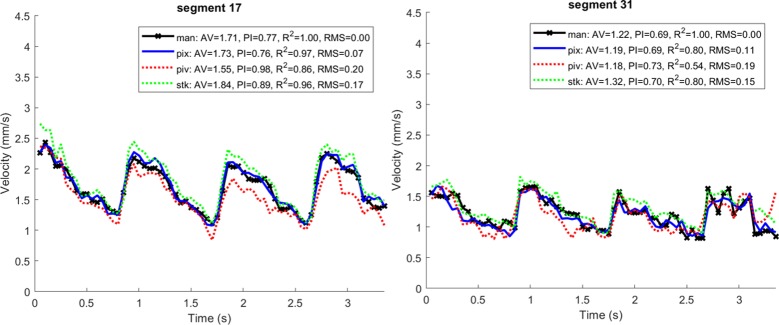
Temporal fidelity in tracking in the face of variability from the cardiac cycle.Sequence was acquired at 300 fps and can be viewed in S3 Video. Two simultaneously imaged segments were tracked manually (left and right panels). Black crosses show manually tracked data, blue shows the output of the proposed PIX method, red shows output for particle image velocimetry (PIV), and green shows output for the spatiotemporal kymograph (STK). The legend shows, from left to right, the average velocity (AV), the pulsatility index (PI, defined as (max-min) / mean), the R2 goodness of fit to manually tracked data, and the root-mean-square (RMS) residual error to manually tracked data.